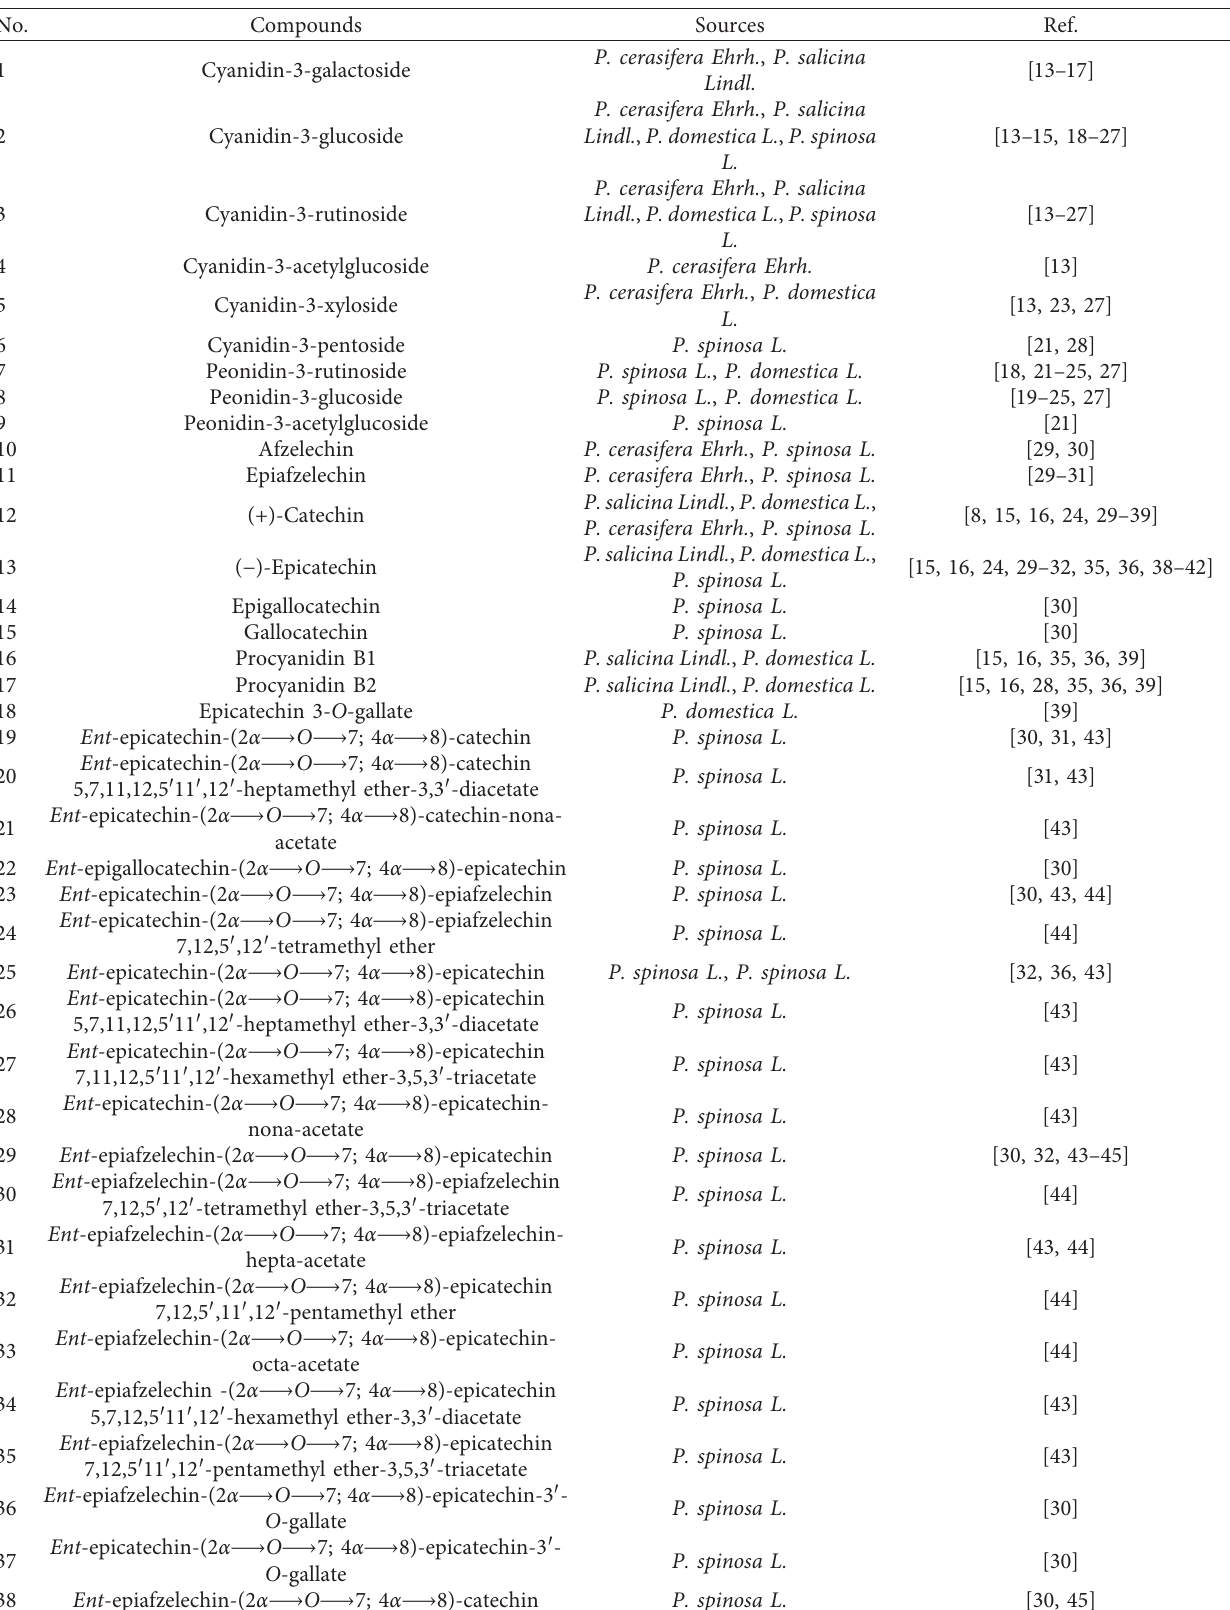
Table 1: Flavonoids compounds isolated and identified from different Prunus